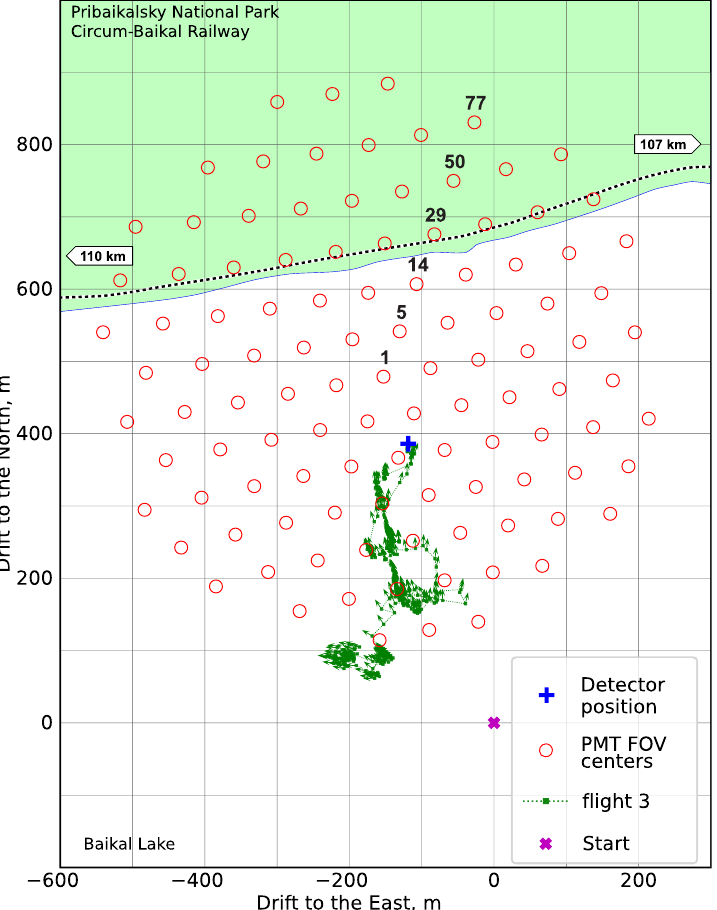
Figure 14. The SPHERE-2 detector drift in 2012-3 flight. Mosaic projection to the show surface is given for the time 15:47 UTC. Detector GPS position at that moment is indicated by the